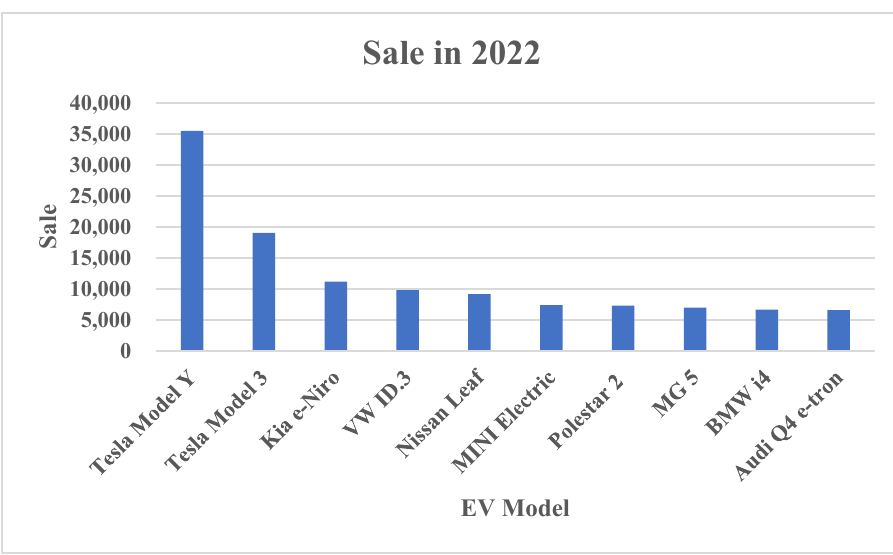
Figure 2. EV registrations and share statistics for 2021 [37].